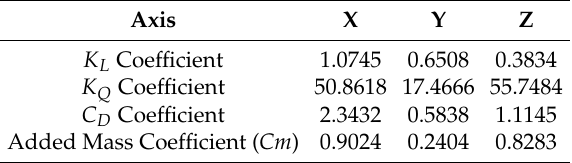
Figure 19. Behaviour of the drag coefficient with respect to speed. It is not possible to determine a characteristic behaviour for each axis. Table 10. Values Obtained through the free decay pendulum